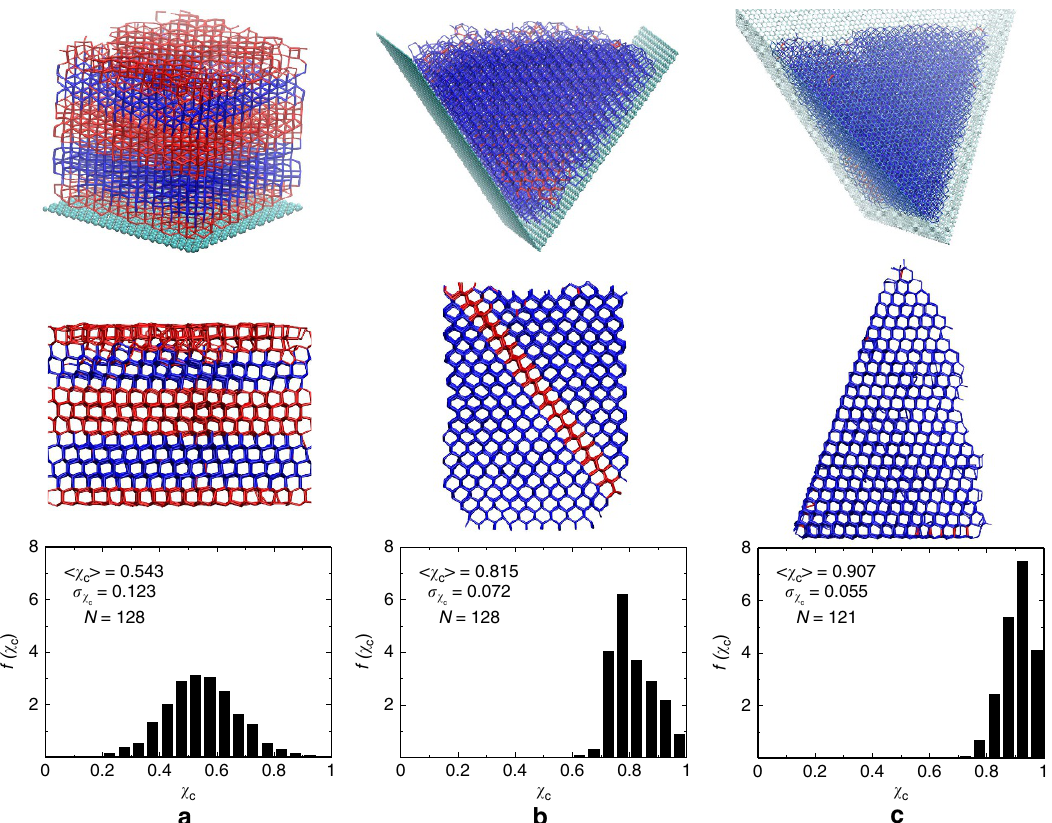
Figure 2 | Enhanced polymorph selection of mW cubic ice I c . Ice exhibits a wide range of cubicity when it crystallizes ( a ) on a flat graphene, ( b ) within a 70 (cid:2) wedge and ( c ) within a tetrahedral pyramid. For each panel, the top and middle rows show the three-dimensional and side views of a representative configuration for fully crystallized ice, respectively. Red and blue represent the hexagonal I h and cubic I c , respectively. The bottom row shows the calculated distribution of cubicity w c , along with the corresponding mean cubicity h w c i , s.d. s w c and number of configurations N used for computing the distribution. Cubicity w c is defined as the fraction of I c in ice I (see Supplementary Note 1 for more